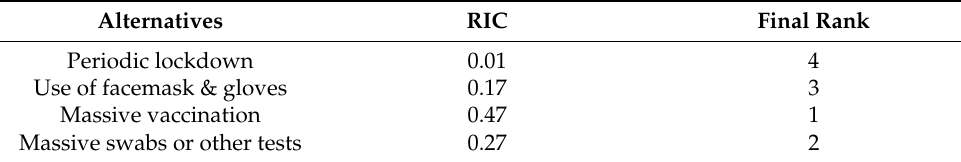
Table 12. The RIC values for alternatives concerning the goal.